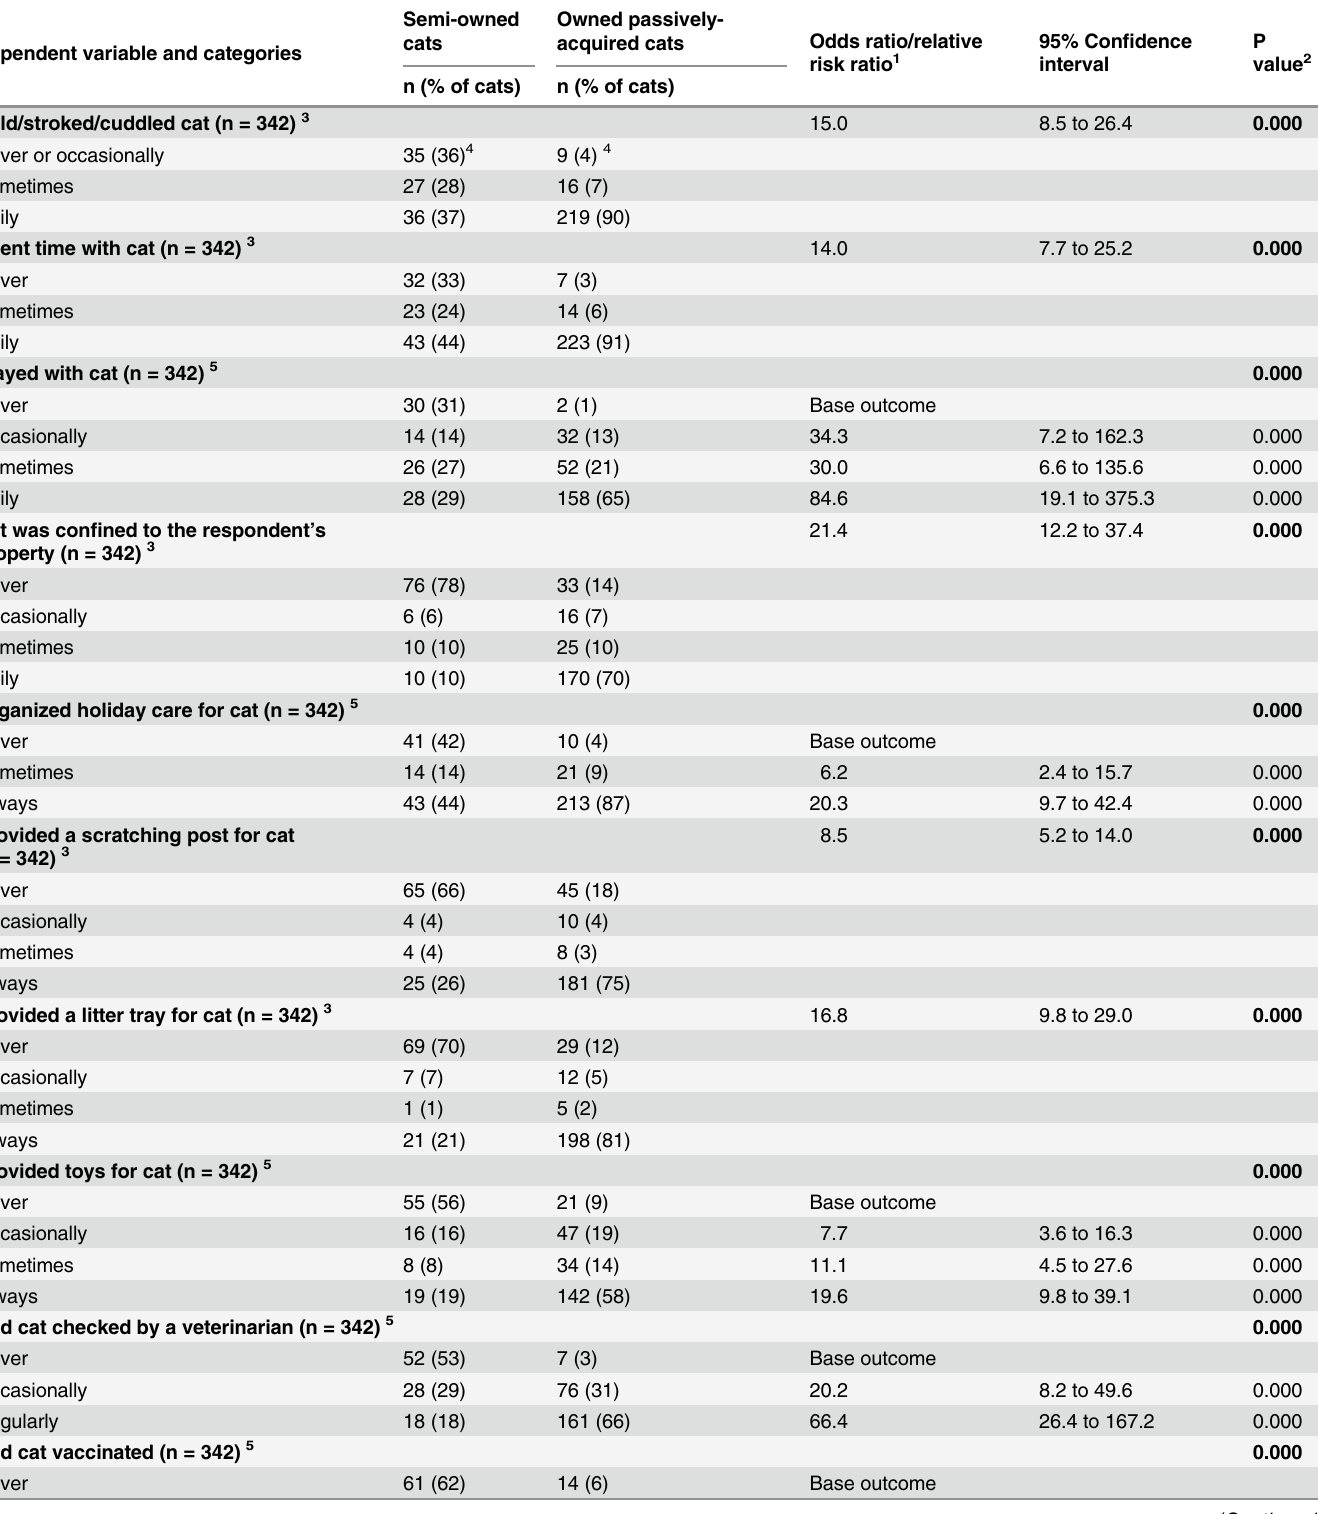
Table 2. Distributions of study cats in semi-ownership and ownership (of passively-acquired cats) human-cat relationships that had received vari- ous interactions and caretaking behaviours and associations between these and perception of ownership of the study